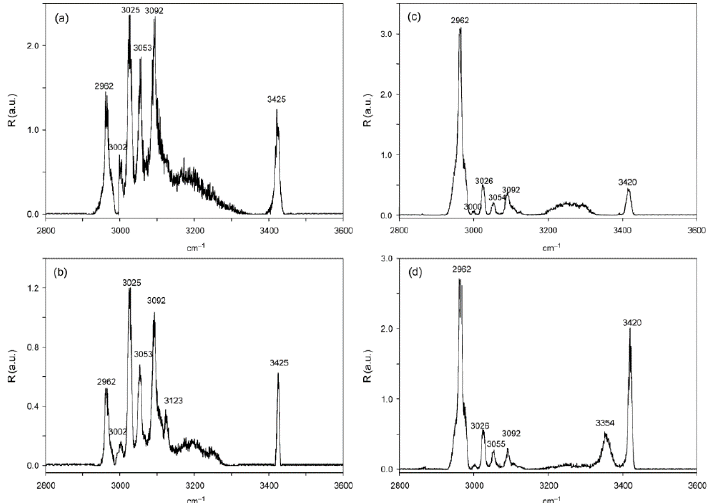
Figure 3. IRMPD spectra of the ESI-formed diastereomeric complexes: ( a ) [R + cytidine + H] + ; ( b ) [S + cytidine + H] + ; ( c ) [R + cytarabine + H] + and ( d ) [S + cytarabine + H] + [25]. Reprinted with permission from Wiley.